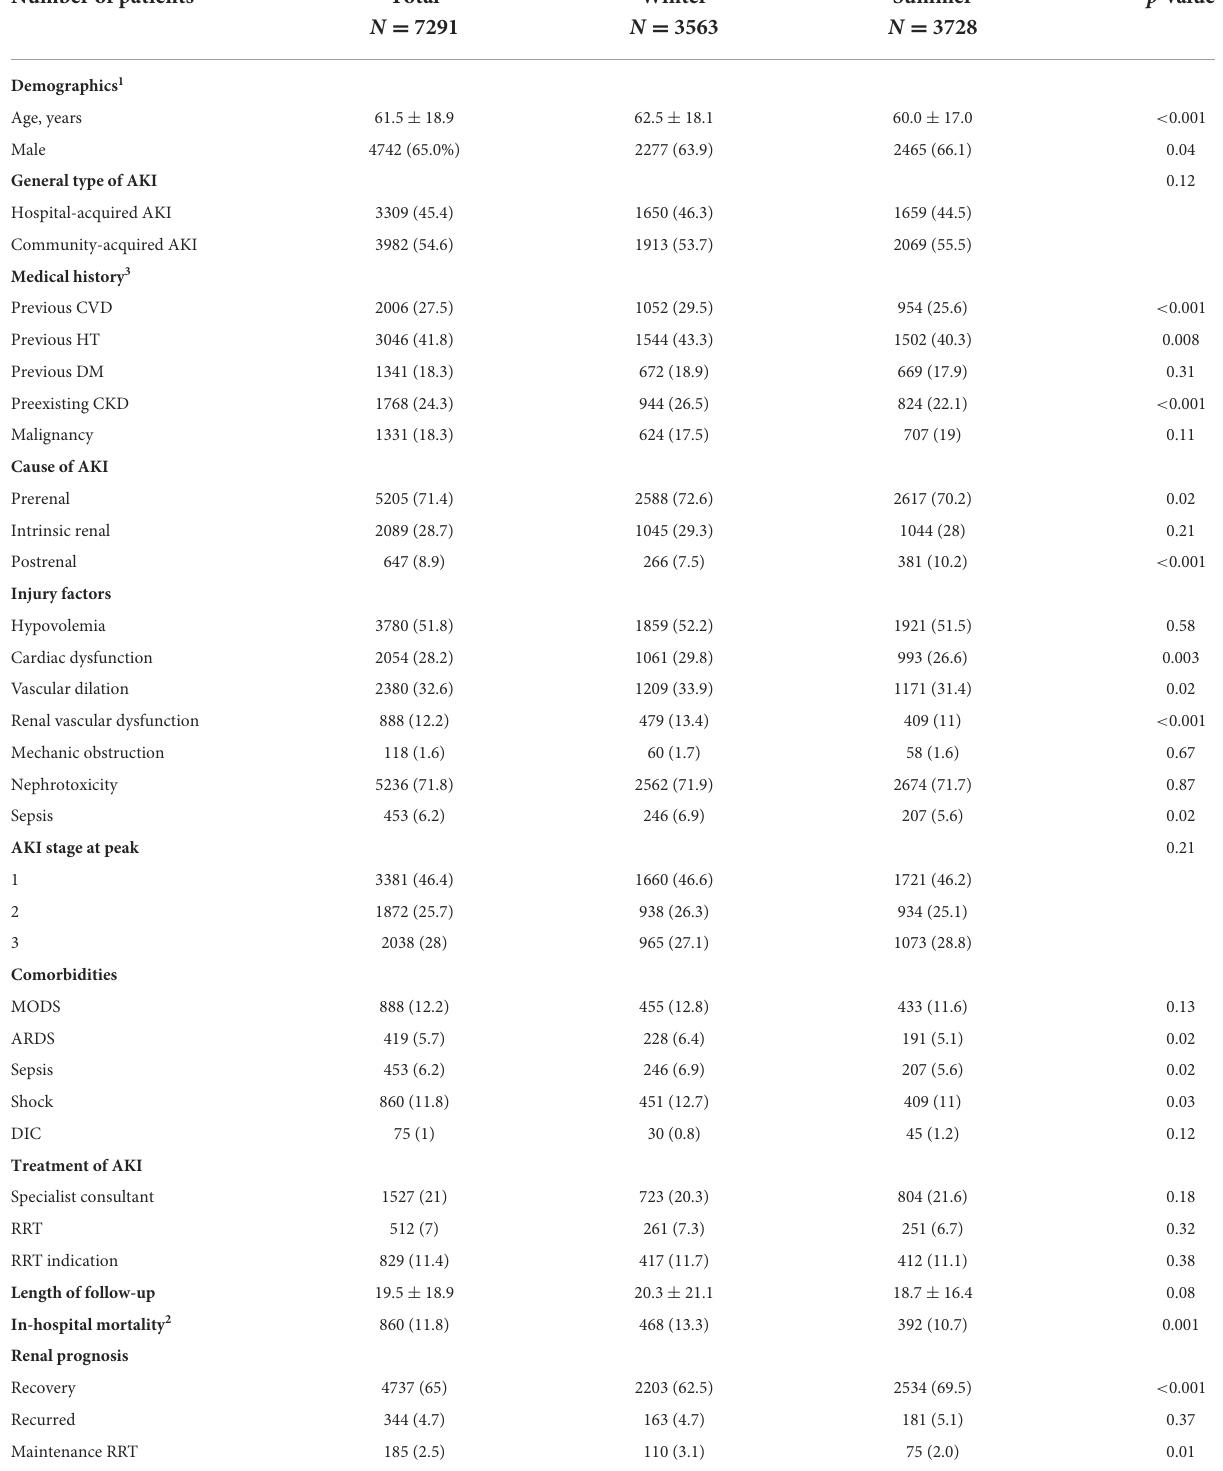
TABLE 2 Comparison of demographic and clinical characteristics of patients with AKI in different